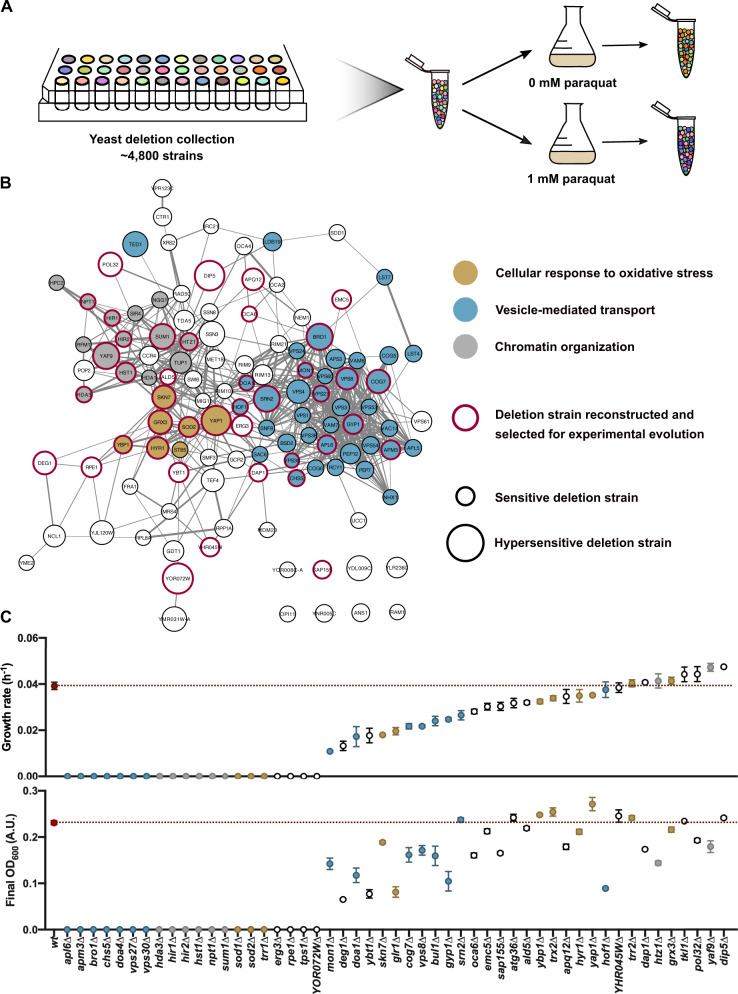
A comprehensive genetic screen identifies cellular processes important for resistance to paraquat stress. (A) Schematic overview of the experiment. All the deletion strains from the haploid deletion collection were pooled, and the pool was grown with and without paraquat to determine the relative fitness of each individual mutant under paraquat stress. (B) Interaction network with the genes that, when deleted, increase sensitivity to paraquat (log FC < −3.5). Three of the most enriched cellular processes are highlighted in gray (chromatin organization), gold (cellular response to oxidative stress), and blue (vesicle-mediated transport). The size of the nodes represents the sensitivity to paraquat as determined in the genome-wide screen. The thickness of the edges represents the confidence score associated with the interaction as determined by STRING. Nodes with red borders represent genes for which deletion mutants were made and which were selected for experimental evolution. (C) Growth rates and final OD600 values after 120 h of deletion strains selected as starting strains for experimental evolution on YP 2% (w/v) glycerol with 0.125 mM paraquat. Error bars represent SEM of four replicate measurements. Strains are colored based on the cellular process they belong to: gray for chromatin organization, gold for cellular response to oxidative stress, and blue for vesicle-mediated transport.